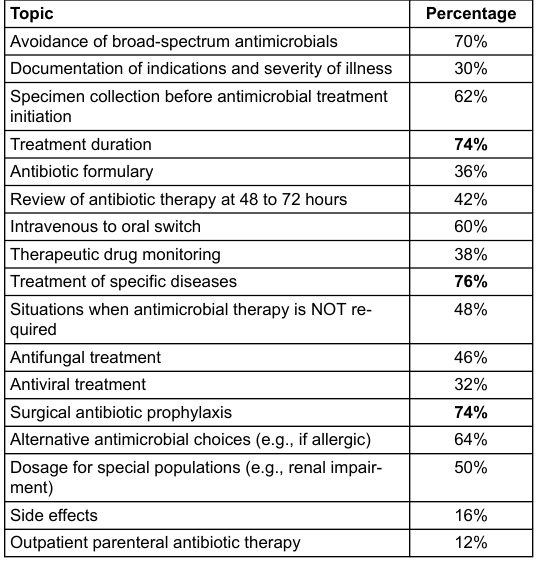
Table 1: Topics covered in antimicrobial treatment guidelines or stew- ardship policy according to the respondents surveyed (n = 50; guide- lines were not available in 13